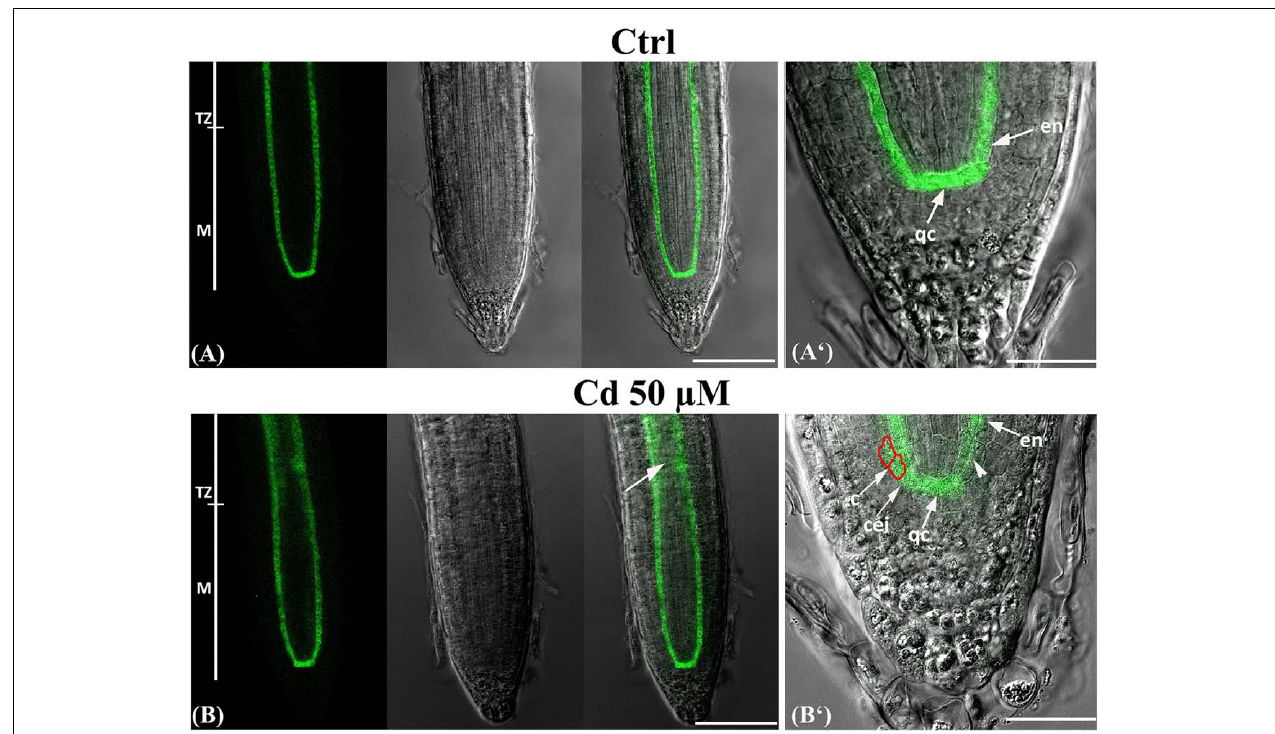
FIGURE 5 | Expression of SCARECROW in the primary root of seedlings of A. thaliana pSCR::SCR-GFP transgenic line germinated (A) on growth medium as control (Ctrl) and on medium added with (B) 50 µ M Cd for 8 days after germination. From left to right: confocal laser image; transmission image; merged image; higher magnification. c, cortex; cei, cortex and endodermis initial; en, endodermis; M, meristematic zone; qc, quiescent center; TZ, transition zone. Scale bars (A,B) 110 µ m; (A ‘ ,B ‘ ) 42 µ